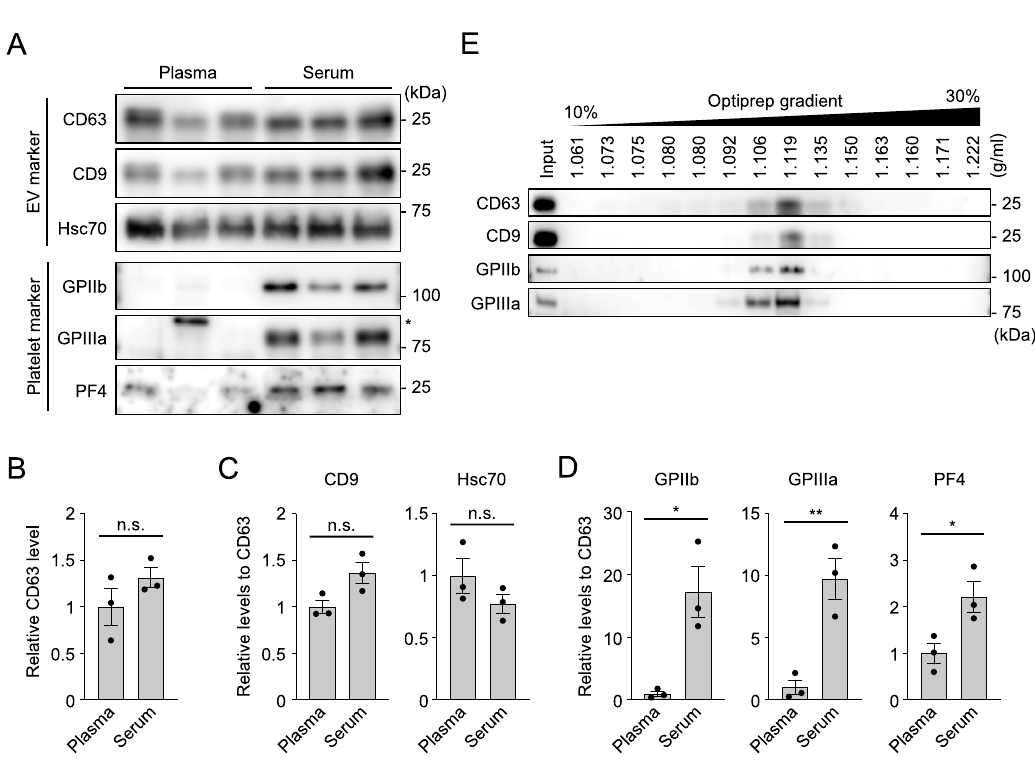
Fig 4. Platelet-specific proteins are abundantly detected in sEV fractions derived from serum of mouse blood. (A-D) Western blot analysis of the sEV fractions derived from plasma and serum using antibodies against EV marker proteins and platelet-specific proteins (A) and their densitometric analyses (B-D). Equal amounts of proteins were loaded onto each lane and analyzed (n = 3). The level of CD63 (B) and the levels of EV markers CD9 and Hsc70 relative to CD63 (C) showed no statistical difference between plasma and serum EVs. In contrast, platelet-specific GPIIb, GPIIIa, and PF4 were significantly increased in the serum sEV fractions (D). The asterisk in (A) indicates a nonspecific signal. (E) Optiprep density-gradient centrifugation analysis of the serum sEV fraction with EV marker proteins and platelet-specific proteins. GPIIb and GPIIIa were both detected in the fractions at the same density as the sEV, and cofractionated with EV markers. Data are shown as the average ± SEM. � P < 0.05, �� P < 0.01, Student t -test. n.s., not